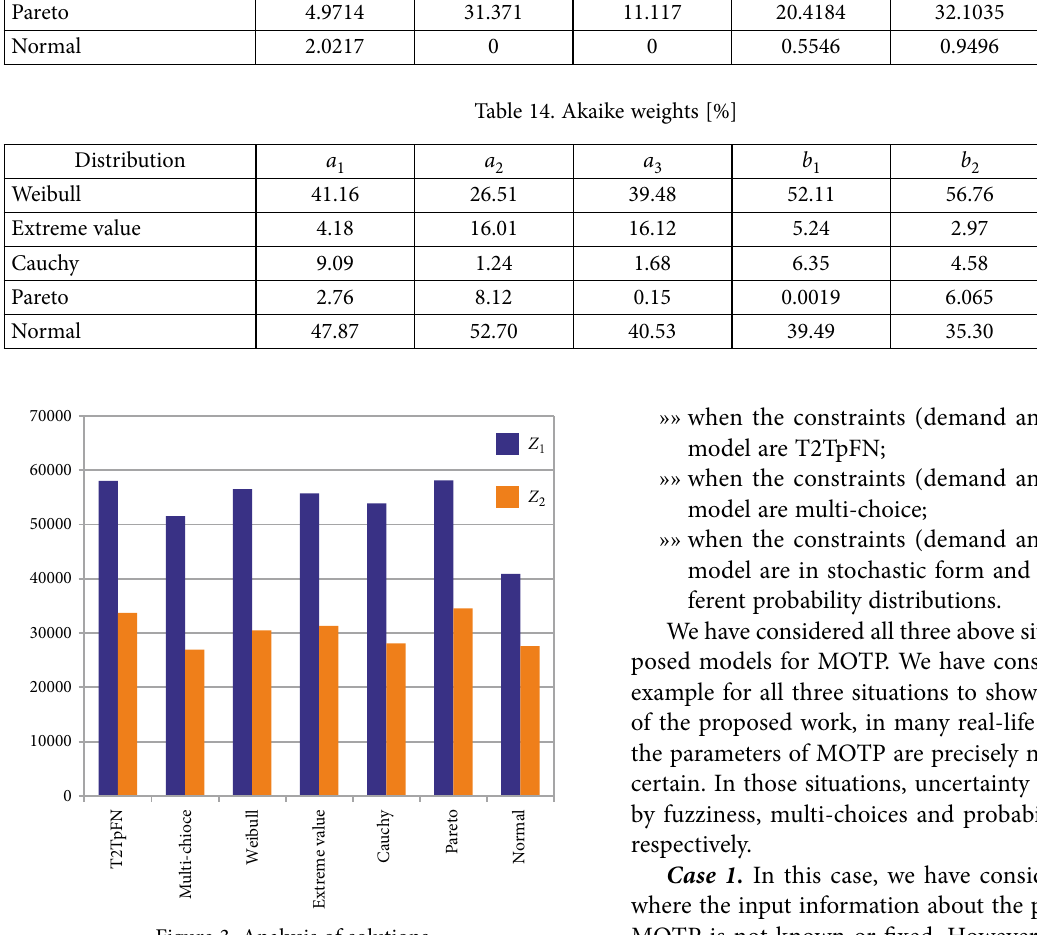
Figure 3. Analysis of